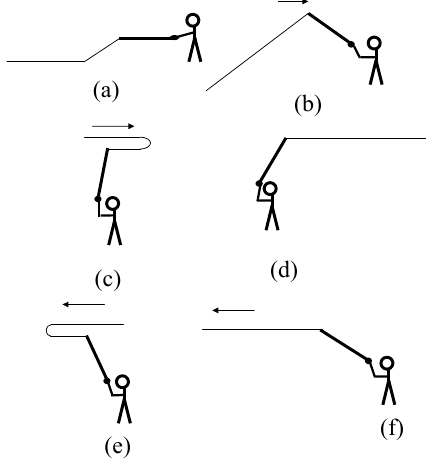
Fig. 2. A typical forward casting sequence.